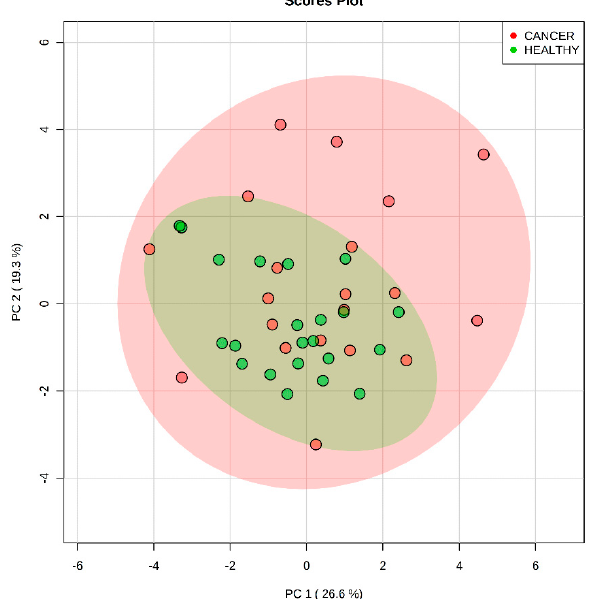
Figure 4. Principal component analysis scores ‐ plot of the differentiation of plasma samples